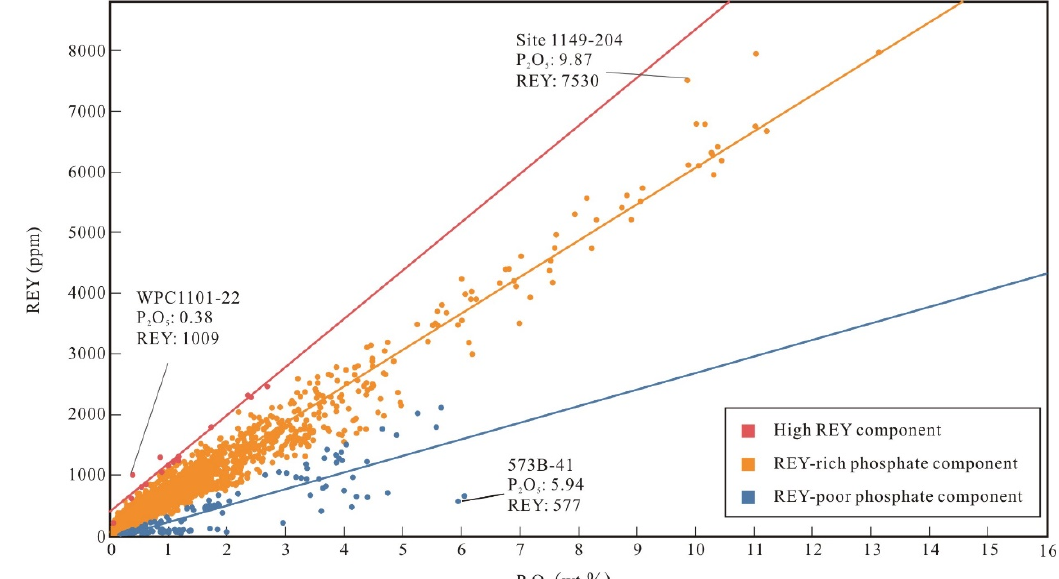
Figure 9. According to the ∑ REY, P content, and Al content, sediment samples can be divided into a high REY component, REY ‐ rich phosphate component, and REY ‐ poor phosphate component. Data sources as in Figure 1.